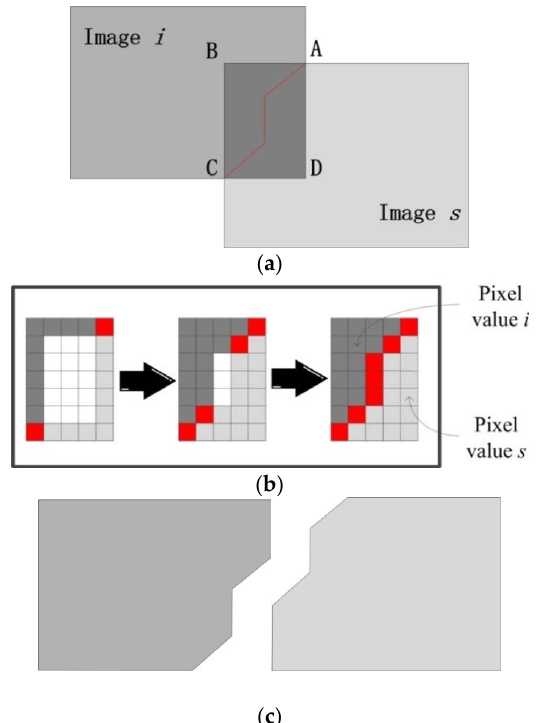
Figure 2. The illustration of the improved seeded region growing algorithm: ( a ) the illustration of the overlap region and the generated seamline; ( b ) the procedure of improved seeded region growing; ( c ) results of cutting image i and image s along the generated seamline.